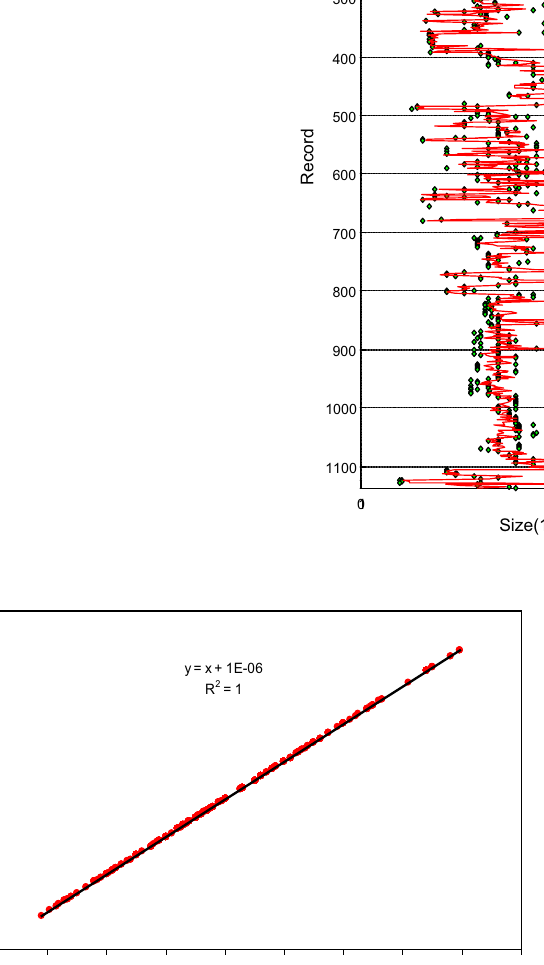
Fig. 10 Correlation between the actual and the predicted choke size for both training and testing data (FL model for Radii = 0.1)